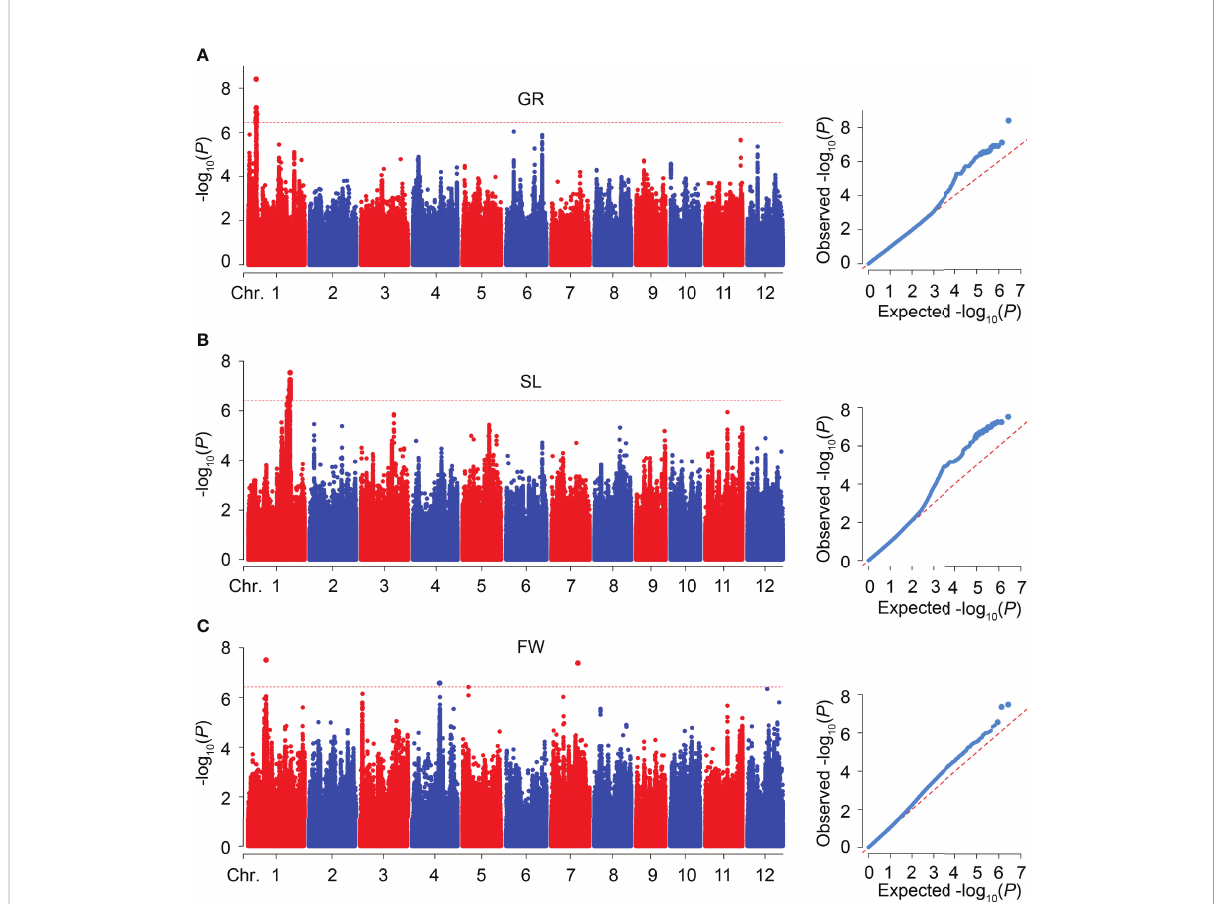
FIGURE 3 GWAS for SV-related traits in 346 rice accessions. (A-C) Manhattan and quantile-quantile (Q-Q) plots of GWAS for GR (A) , SL (B) , and FW (C) , respectively.